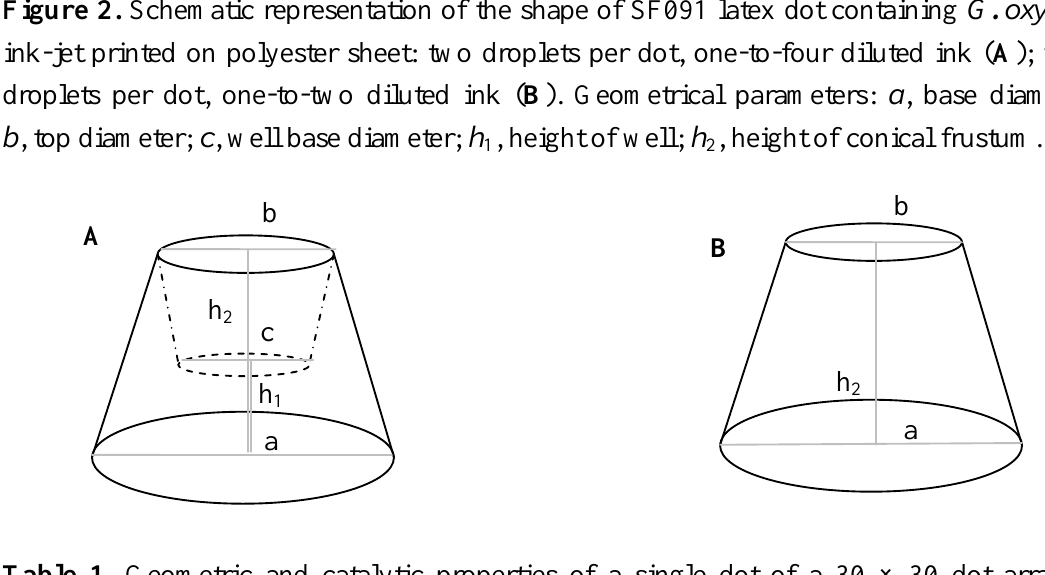
Table 1. Geometric and catalytic properties of a single dot of a 30 × 30 dot array of G. oxydans latex ink-jet microstructure printed on a polyester sheet. Geometric parameters were determined by ImageJ software starting from images obtained by Talymap Platinum software (Taylor Hobson Precision, Leicester, England). Mean and standard deviation of measurements from three dots are